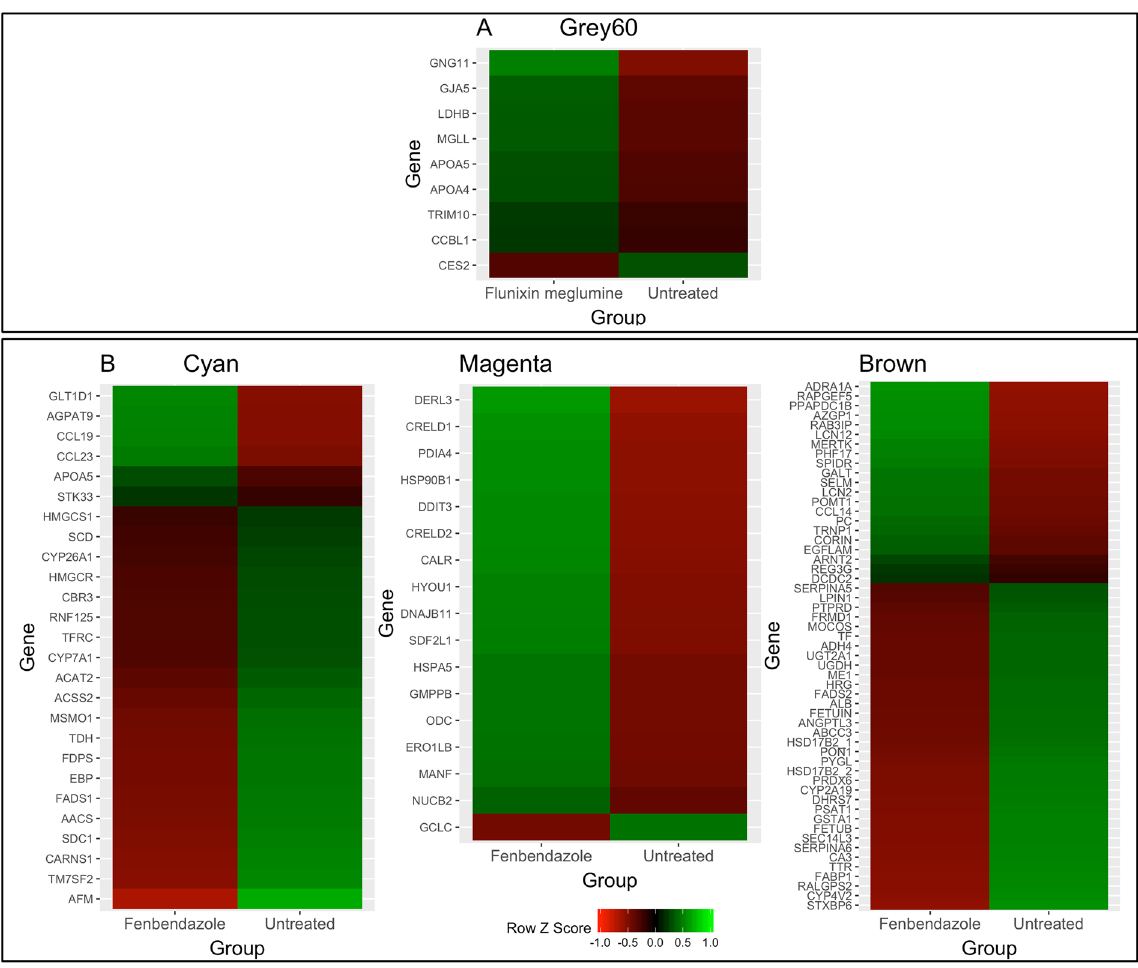
Figure 4. Expression profiles of genes with significant differences in transcript levels across animals administered Flunixin Meglumine (Panel A) and Fenbendazole (Panel B) versus untreated animals within modules associated with pharmacokinetic